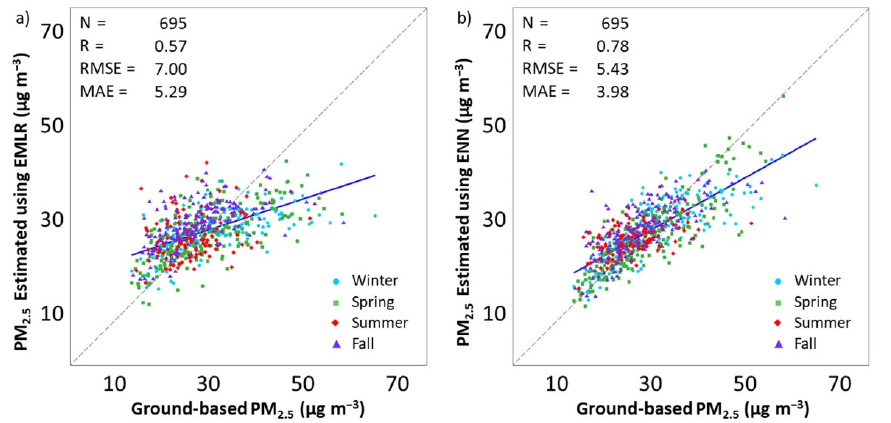
Figure 6. Statistical performance of the ( a ) ensemble multiple linear regression (EMLR) and ( b ) ENN models to estimate the daily mean PM 2.5 over the MMA from January 2010 to December 2017. The dash line shows the 1:1 line as a reference.